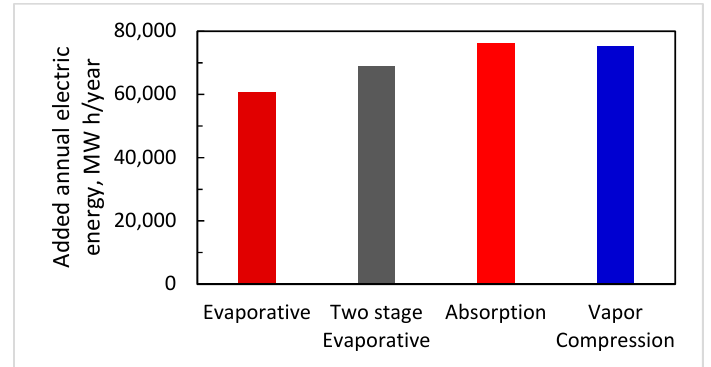
Figure 13. Added annual electric energy (MW h/year).